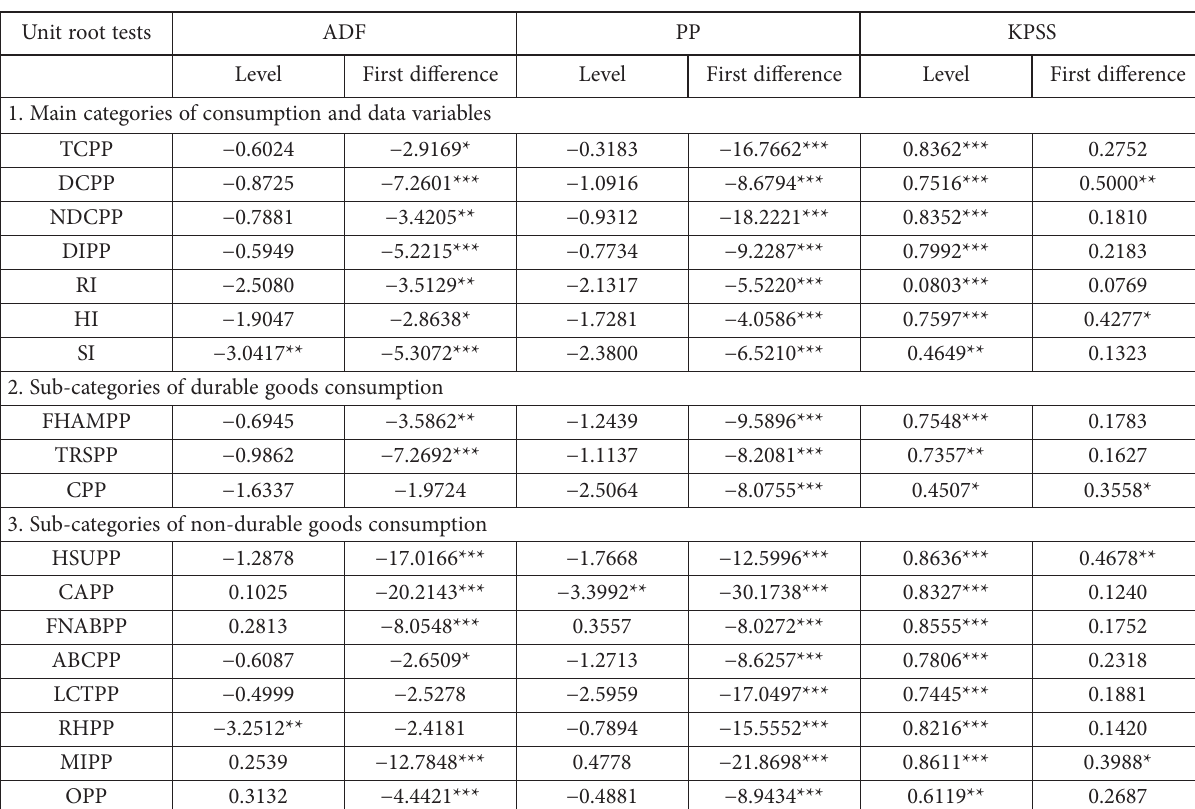
Table 4. Test for unit